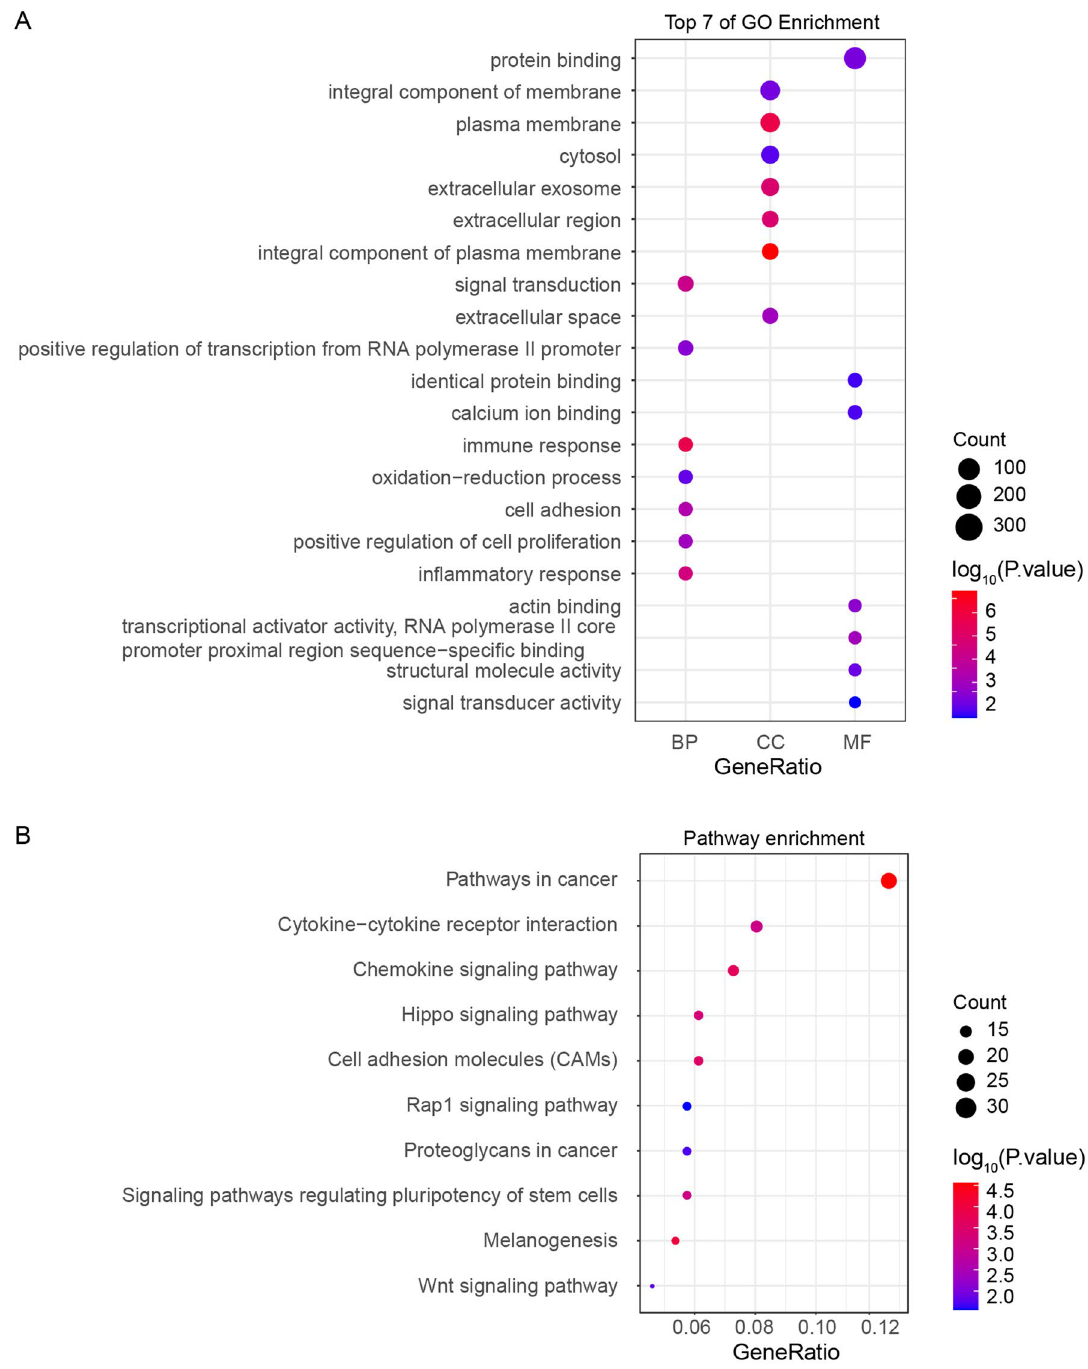
Figure 2. GO and KEGG pathway enrichment analysis of the DEGs. ( A ) GO analysis of DEGs, including biological processes, cell components, and molecular functions. ( B ) KEGG pathway enrichment analysis of the DEGs. The GO analysis and KEGG pathway enrichment analysis of the DEGs were completed using DAVID and visualized using the ggplot2 package. GO gene ontology, KEGG Kyoto Encyclopedia of Genes and Genomes, DEG differentially expressed